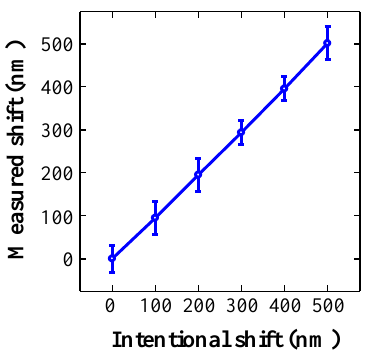
Figure 5. Evaluation of linearity in the detection of markers. Error bar shows 3 σ range.